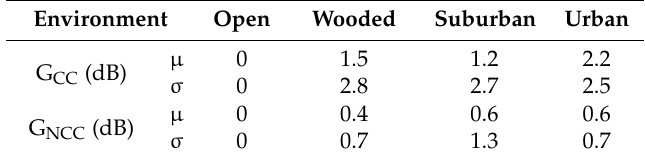
Table 4. Angular combining improvement (in dB). G CC : coherent combining; G NCC : non-coherent combining. Environment Open Wooded Suburban Urban µ 0 1.5 1.2 2.2 G CC (dB) σ 0 2.8 µ 0 G NCC (dB)